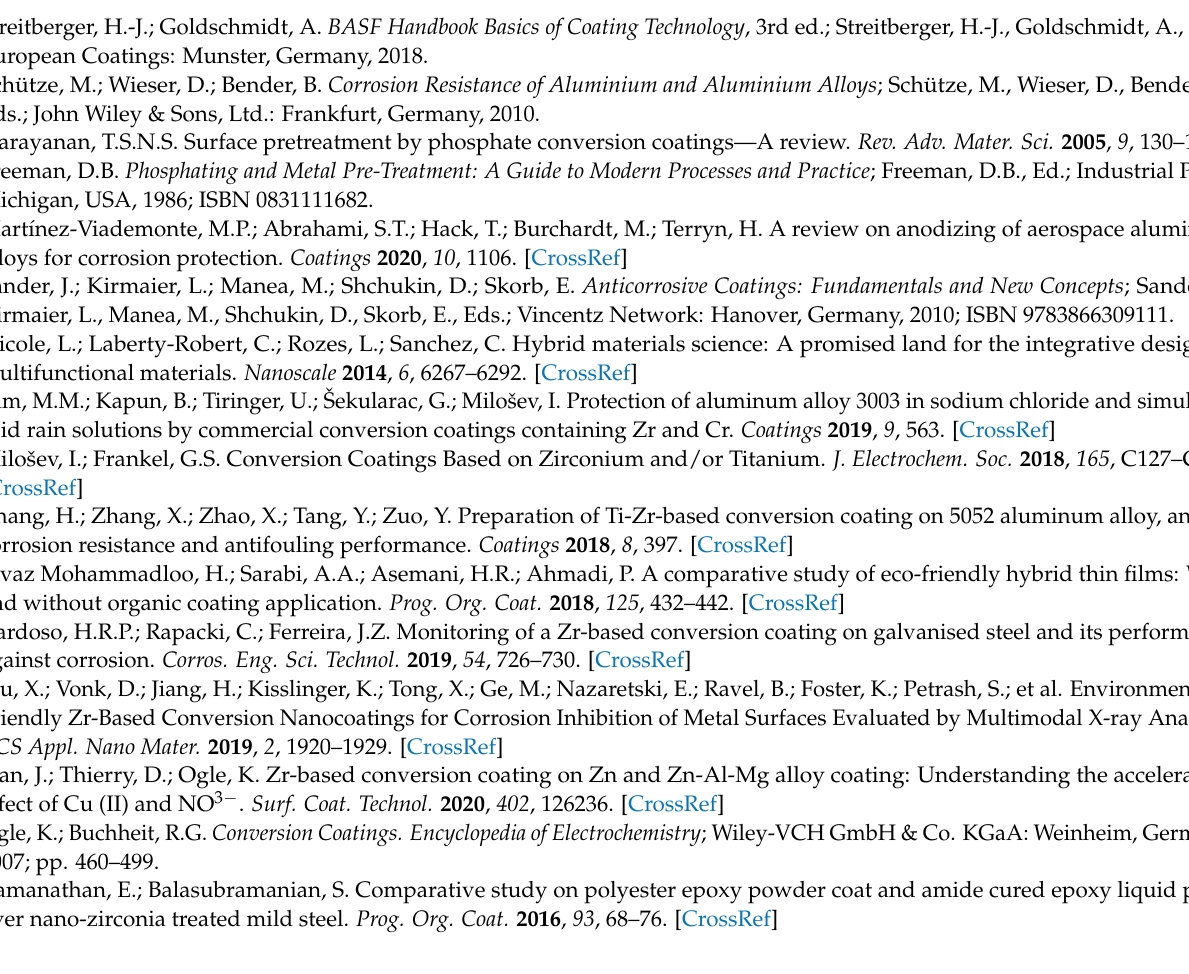
Table S3: Corrosion potentials (E corr ) and corrosion current densities (j corr ) measured by Tafel fitting of the experimental curves obtained after samples immersion in NaCl 0.05 M for 30 min; Table S4: Electrochemical impedance parameters for all samples, after immersion in NaCl 0.5 M for 30